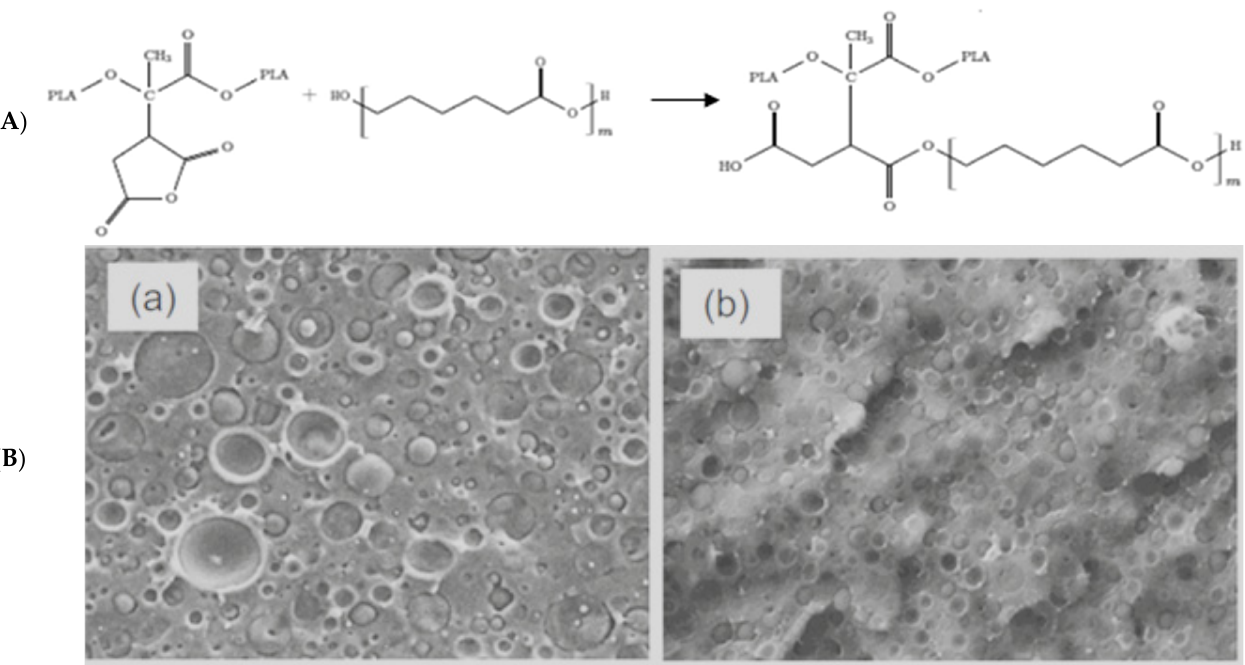
Figure 12. ( A ) Proposed reaction scheme between PLA- g -MA and PCL ( B ) SEM micrographs of PLA/PCL blends ( a ) without and ( b ) with 10% PLA- g -MA (adapted from Gardella et al. [55], copy- right Springer, reproduced with